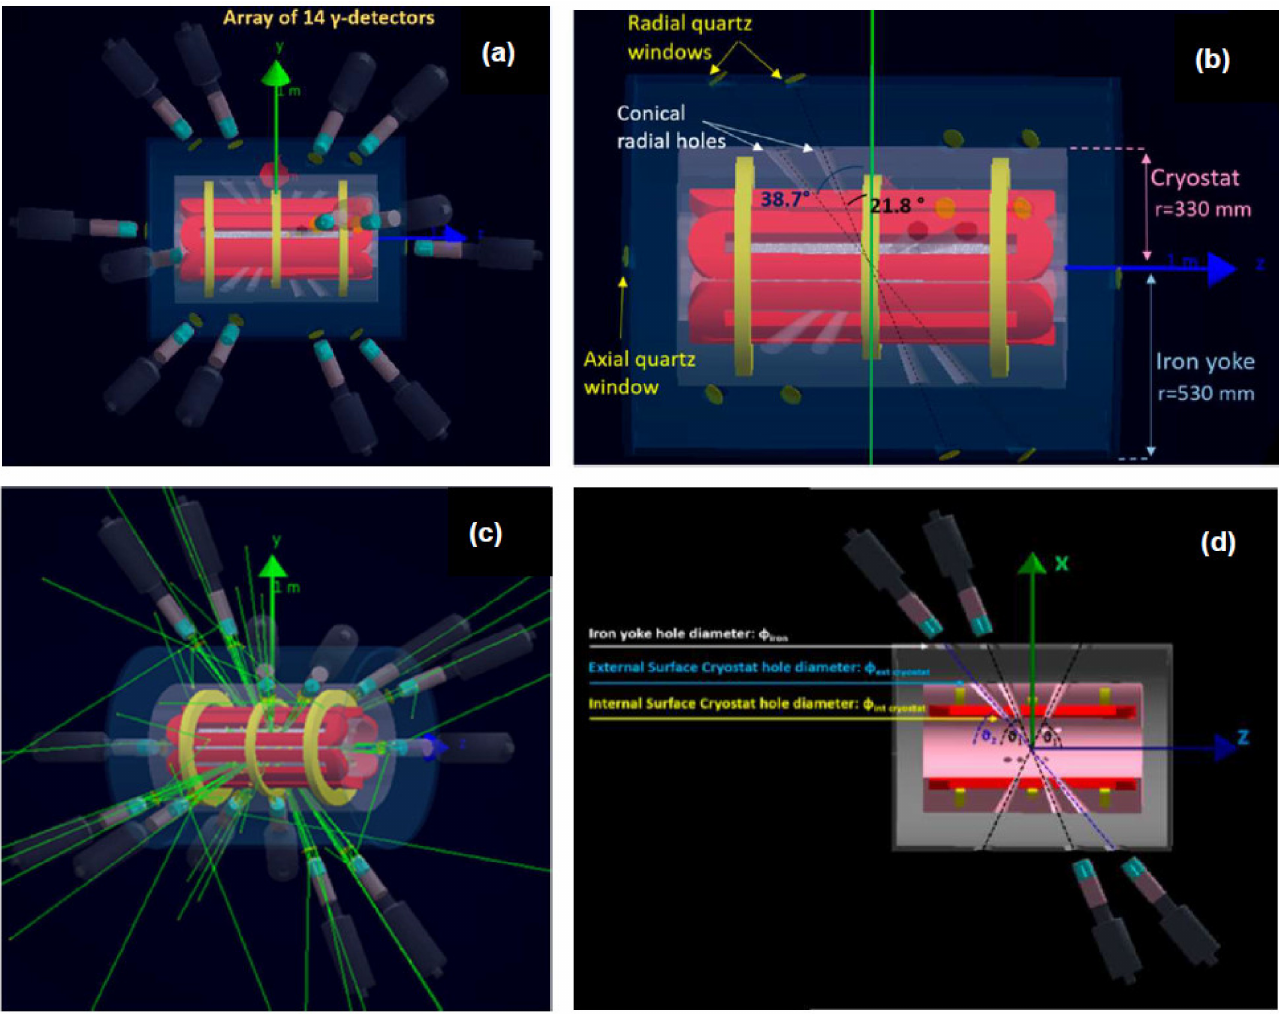
Figure 4. (a – b ) Schematic drawings of the trap with holes for HPGe detectors, also including the detectors’ displacement and system sizes. ( c ) GEANT4 simulations of γ -rays emitted from the plasma considering the magnetic system and detectors array. ( d ) Cut view of the experimental setup, showing the magnetic system, the lines of sight. and detectors’